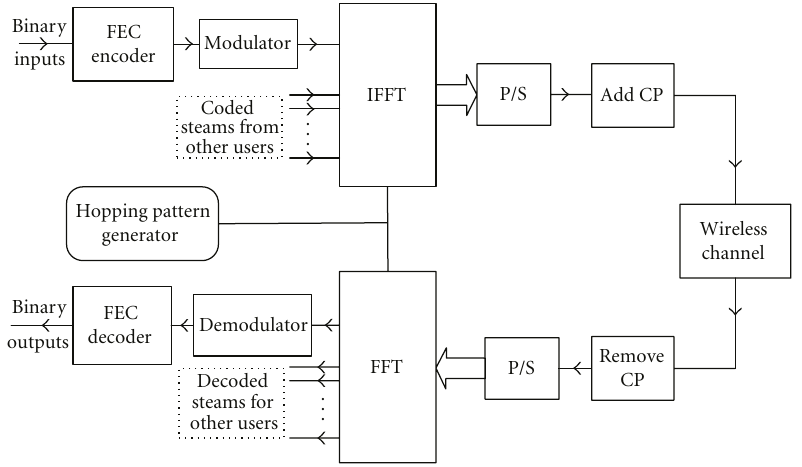
Figure 1: The block diagram of coded FH-OFDMA